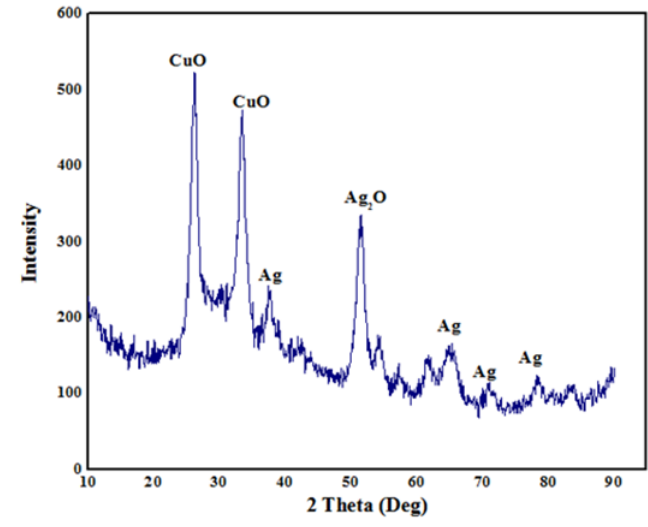
Figure 7. XRD pattern of fungal biomass-mediated Ag/Cu NPs.